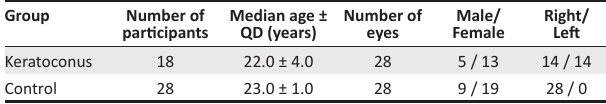
TABLE 1: Demographic information for eyes